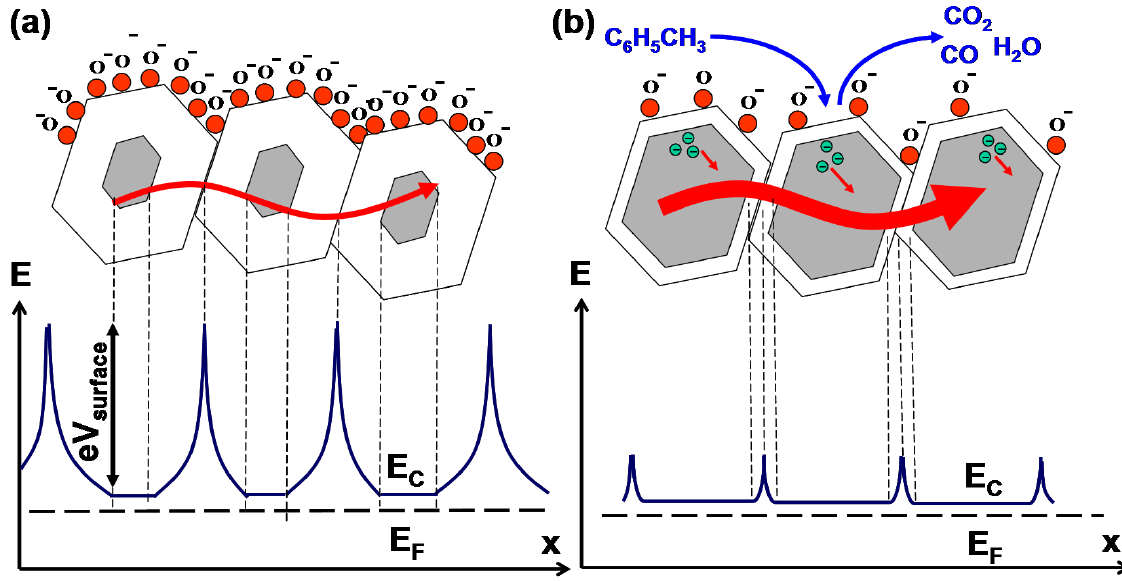
Figure 4. Schematic energy-level diagrams of the polycrystalline ZnO layer ( a ) prior to exposure to toluene and ( b ) after exposure and subsequent oxidation of